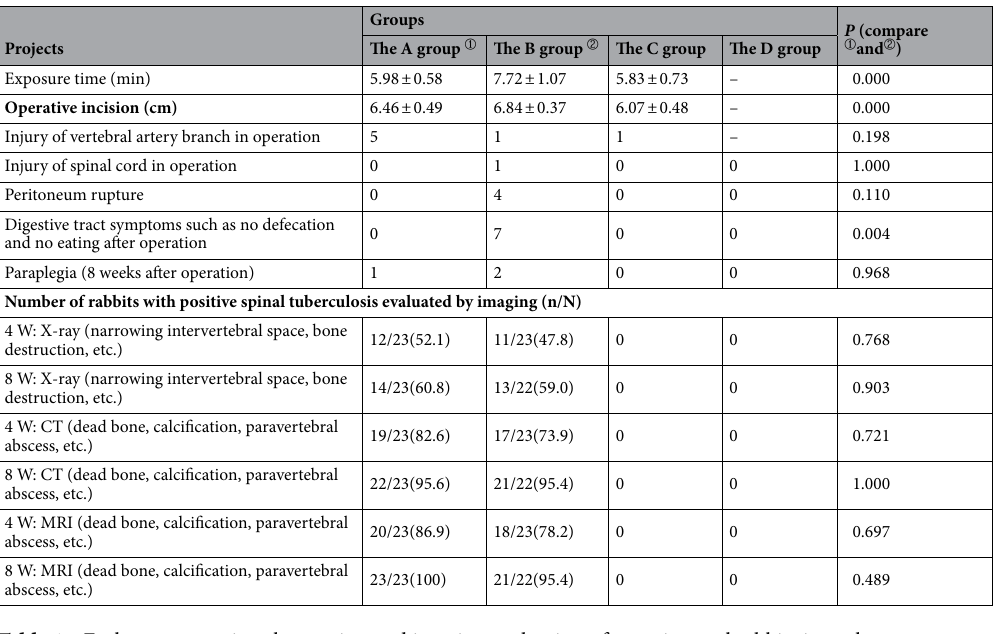
Table 1. Early postoperative observation and imaging evaluation of experimental rabbits in each group.